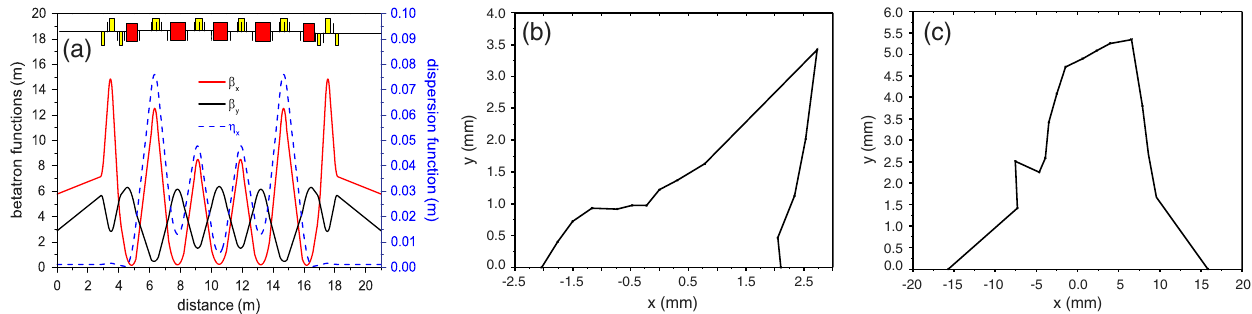
FIG. 5. Lattice A. The betatron function and dispersion function [plot (a)], the dynamic aperture obtained by the MAD HARMON command [plot (b)], and the dynamic aperture obtained by NSGA-II [plot (c)]. The emittance value is 67.9 pm rad. The tune in the horizontal and vertical plane is (cid:6) x ¼ 46 : 405 505 and (cid:6) y ¼ 26 : 484 499 . The natural chromaticities of both planes are (cid:5) ¼ (cid:1) 140 : 440 135 and (cid:5) ¼ (cid:1) 44 : 136 350 , respectively. The corrected chromaticities are (cid:5) x y